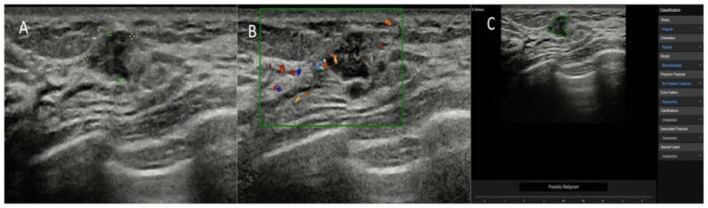
The breast lesion of an asymptomatic 50-year-old woman. (A) The longitudinal section of a 9-mm lesion. (B) Color Doppler flow imaging of the lesion. The diagnosis of the experienced radiologists was a BI-RADS 3 lesion. (C) The diagnosis of the deep learning-based CAD system was a possibly malignant tumor. The pathological result was invasive ductal carcinoma.